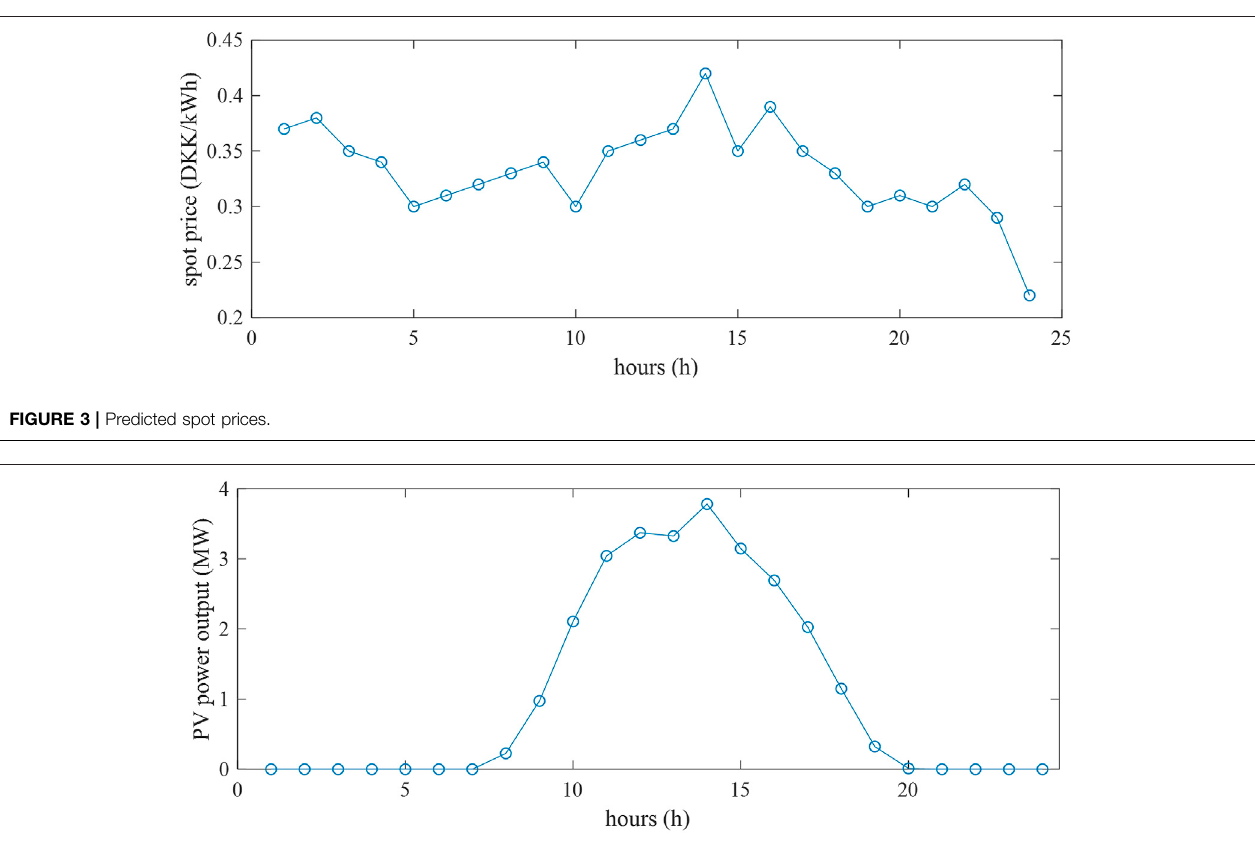
FIGURE 4 | PV active power generation.